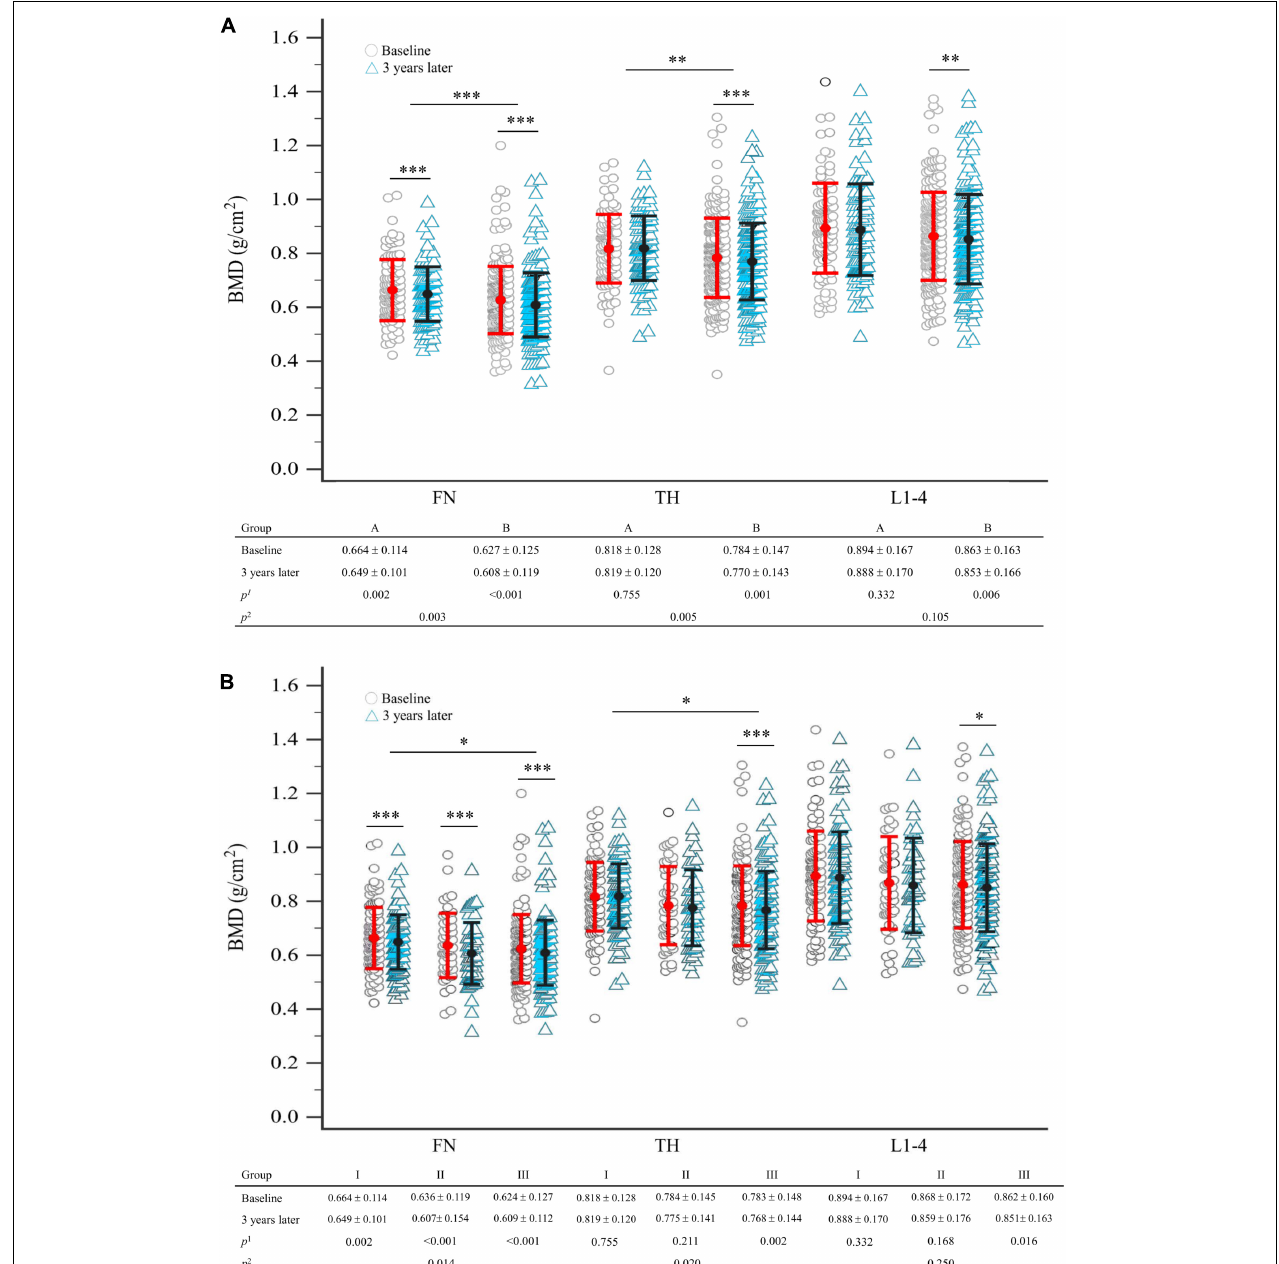
FIGURE 2 | (A) Comparison of BMD between baseline and 3 years later between seronegative (group A) and seropositive (group B) rheumatoid arthritis, after matching; (B) comparison of BMD between baseline and 3 years later in total groups stratified by the number of antibodies presented, after matching. Statistical analysis using the linear mixed model; p 1 -value refers to intra-group comparison; p 2 -value refers to inter-group comparison. The error bar represents the standard deviation for the means. Each symbol represents a single data point. BMD, bone mineral density; FN, femoral neck; L1–4, first through fourth lumbar vertebra; TH, total hip. ∗ p < 0.05; ∗∗ p < 0.01; ∗∗∗ p < 0.005.